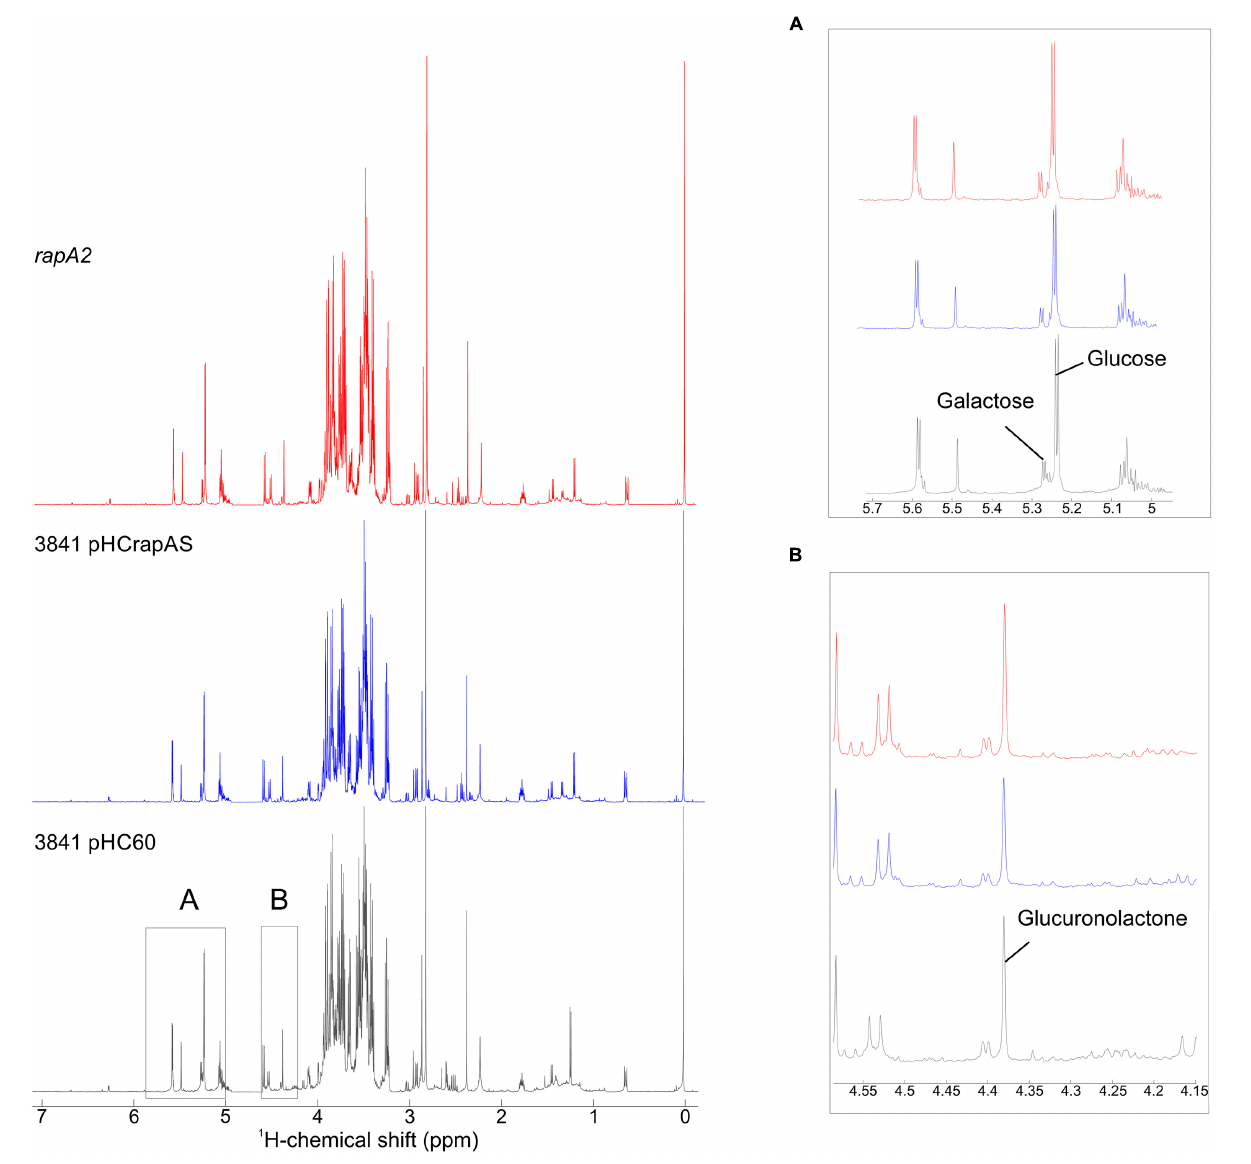
FIGURE 9 | 1 H NMR spectra of hydrolyzed samples of EPS. Purified EPS from strains 3841 harboring pHC60 or pHCrapAS and the rapA2 mutant were hydrolyzed under acidic conditions and analyzed by 1 H NMR spectroscopy. Insets show expanded areas of the spectra. (A) The identification of Glc, Gal, and GlcA was performed using standard commercial sugars. The peaks at δ 5.241 and 5.234 correspond to Glc, while the signals at δ 5.273 and 5.266 are characteristic of Gal. Determination of the ratio Glc:Gal was done by integration of peak areas, resulting in 5.02 (3841 pHC60), 4.98 (3841 pHCrapAS), and 4.95 ( rapA2 ). (B) The signal at δ 4.38 corresponds to the lactone form of GlcA obtained under the assay hydrolysis